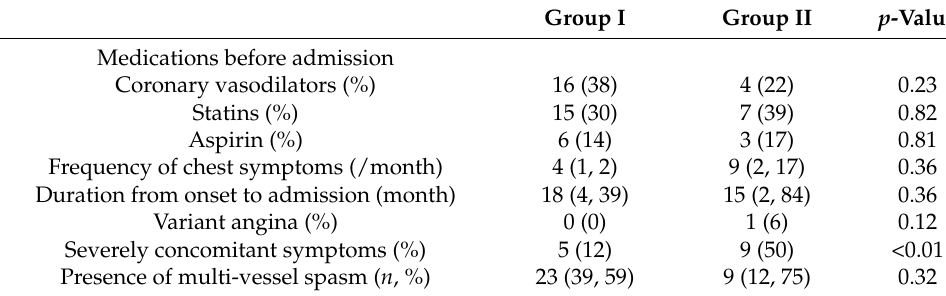
Table 3. VSA-related